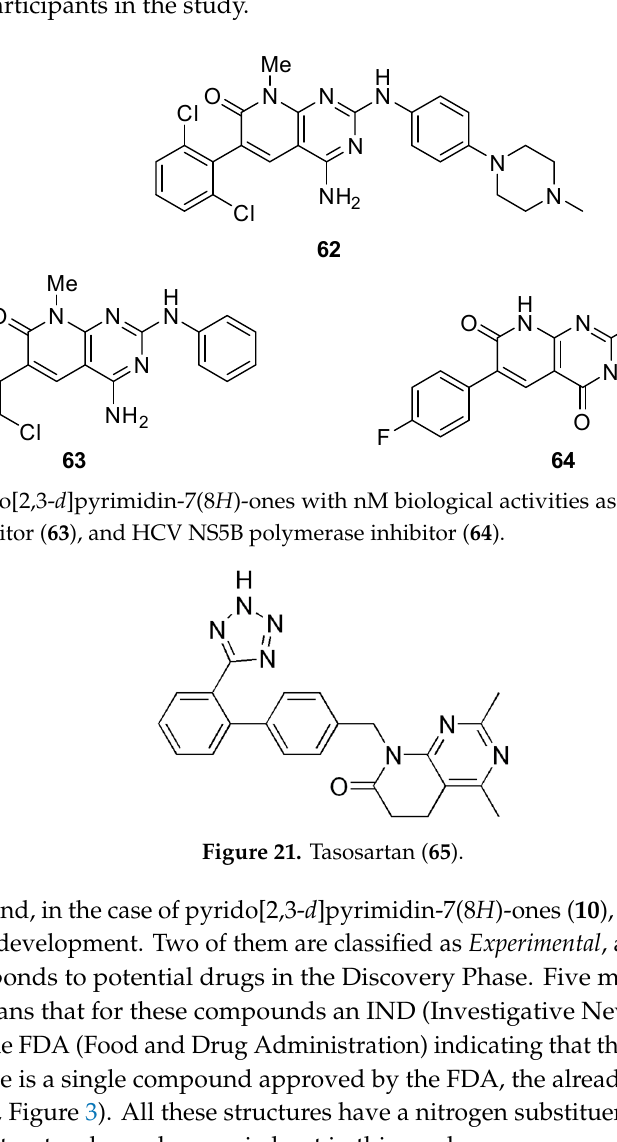
Figure 20. Pyrido[2,3- d ]pyrimidin-7(8 H )-ones with nM biological activities as BCR kinase inhibitor ( 62 ), DDR2 inhibitor ( 63 ), and HCV NS5B polymerase inhibitor ( 64 ) .